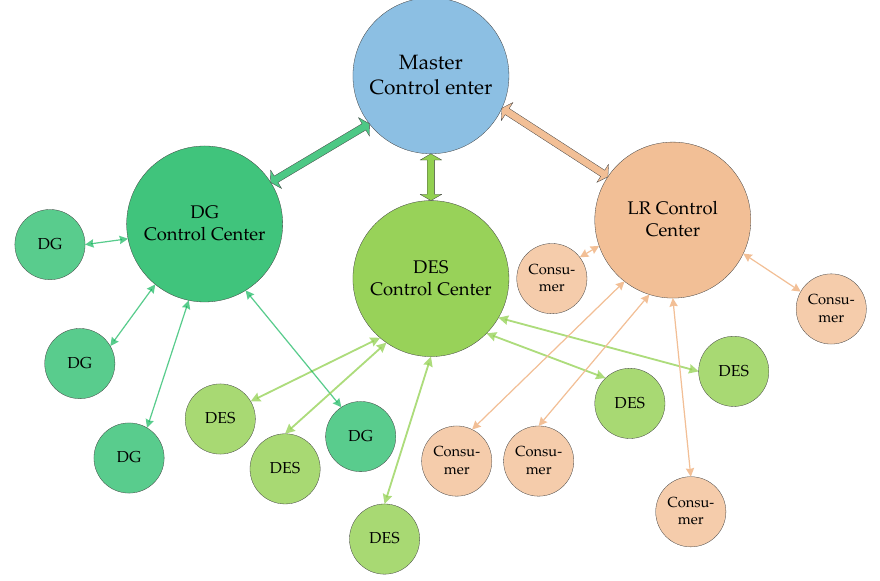
Figure 2. The hierarchical control mode of the ELAN-EMS (energy management system).